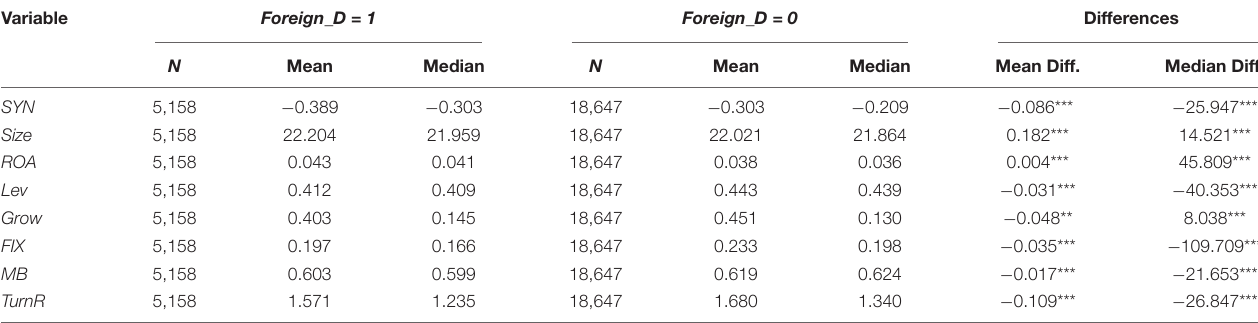
TABLE 3 | Univariate